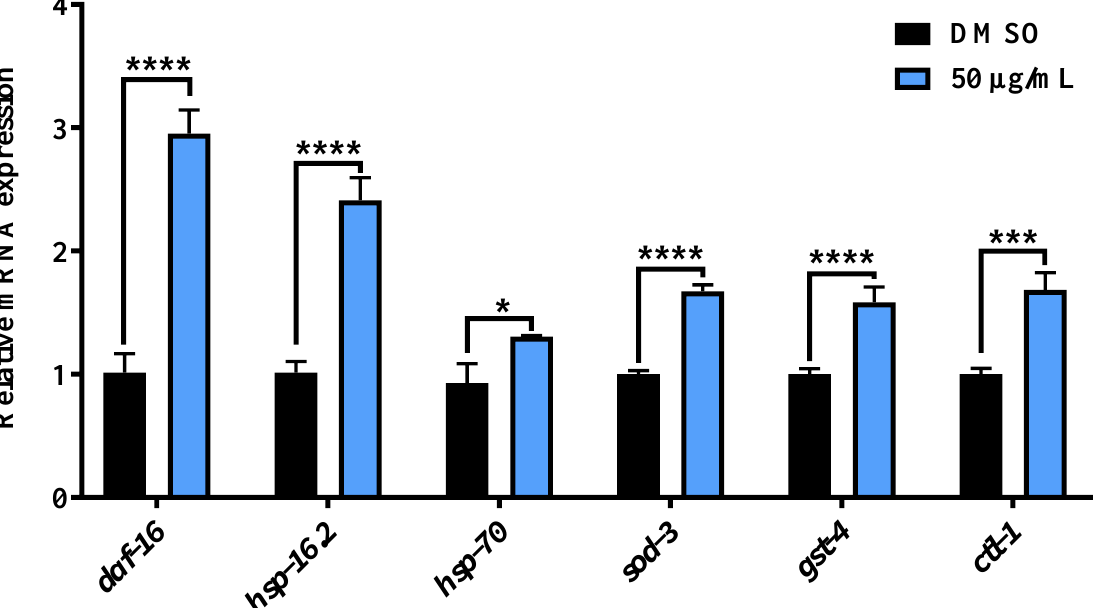
Figure 5. Effects of AE on the mRNA expression daf-16 and its target genes in wild type C. elegans . Worms were cultured at 20 °C on NGM-OP50 plates, treated with or without AE (50 µg/mL) for 96 h ( n ≈ 500 worms/group). Statistical differences compared to control (DMSO) were considered significant at * p < 0.05, *** p < 0.005 and **** p < 0.0001 by multiple t tests. Data were represented by mean ± SD. Experiments were performed in triplicate determinations.